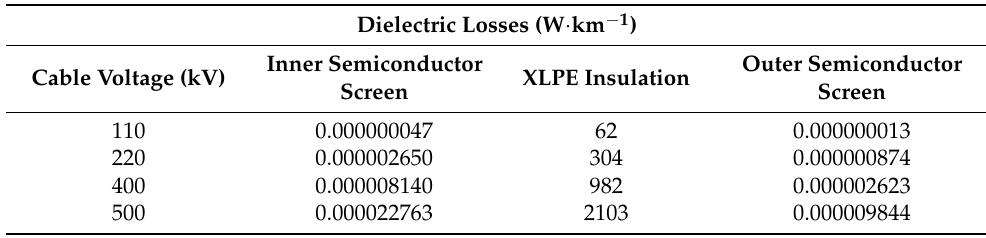
Table 5. Dielectric losses in semiconductor screens and XLPE insulation of high-voltage cables with 110, 220, 400, and 500 kV for 1 km of